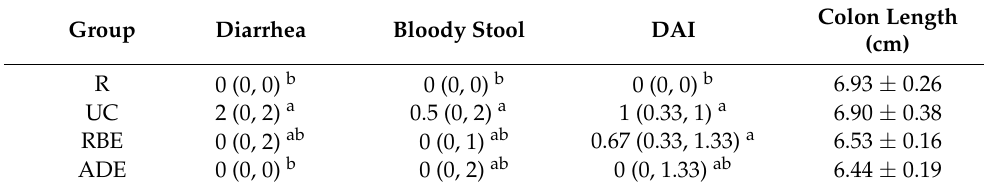
Colon Length (cm)